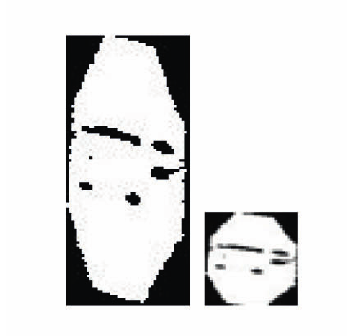
Figure 4. Perspective projection can be solved by size